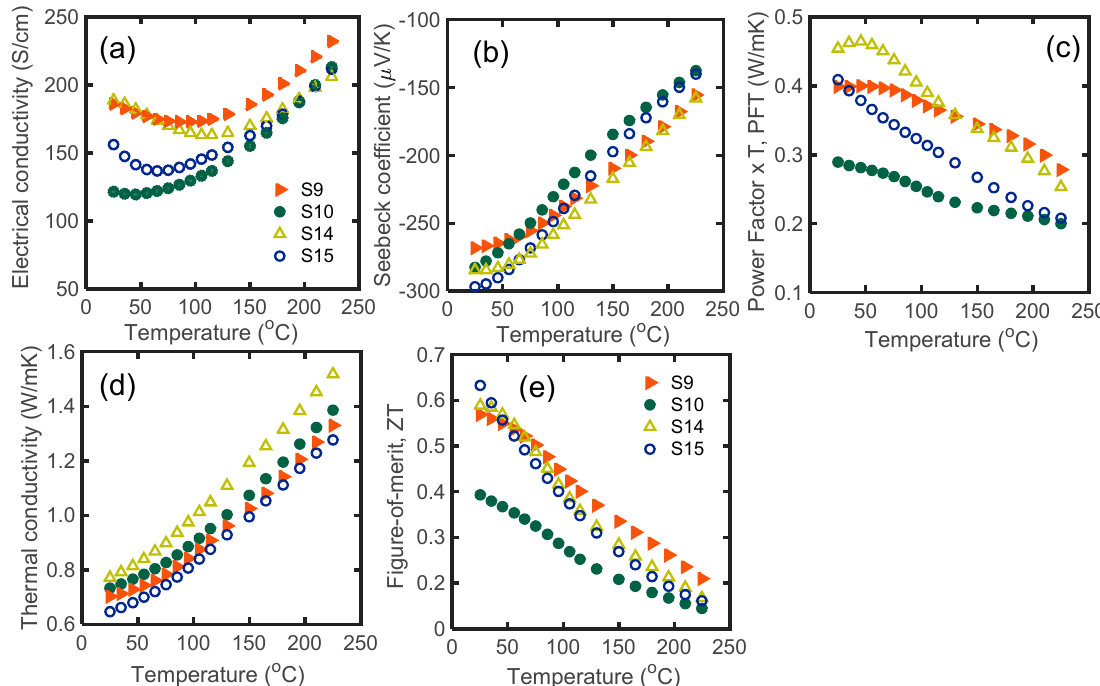
Figure 5. ( a ) Electrical conductivity; ( b ) Seebeck coefficient; ( c ) PFT; ( d ) thermal conductivity; and ( e ) zT of S7, S8, S9, and S10 as a function of temperature in the range of 25 °C to 225 °C. According to Table 1, S9 and S10 are the microwave processed forms of S7 and S8, respectively.